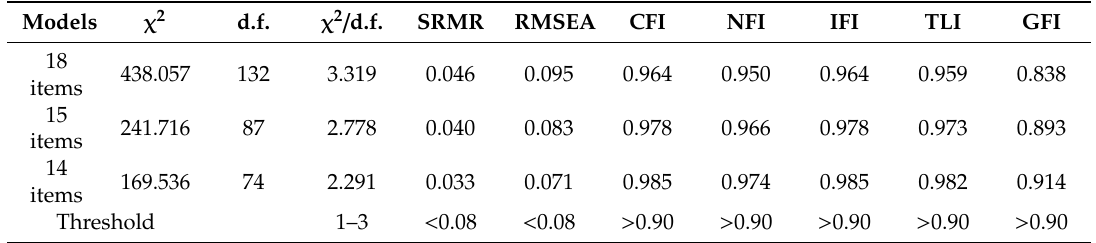
Table 4. Correlation matrix of the constructs.